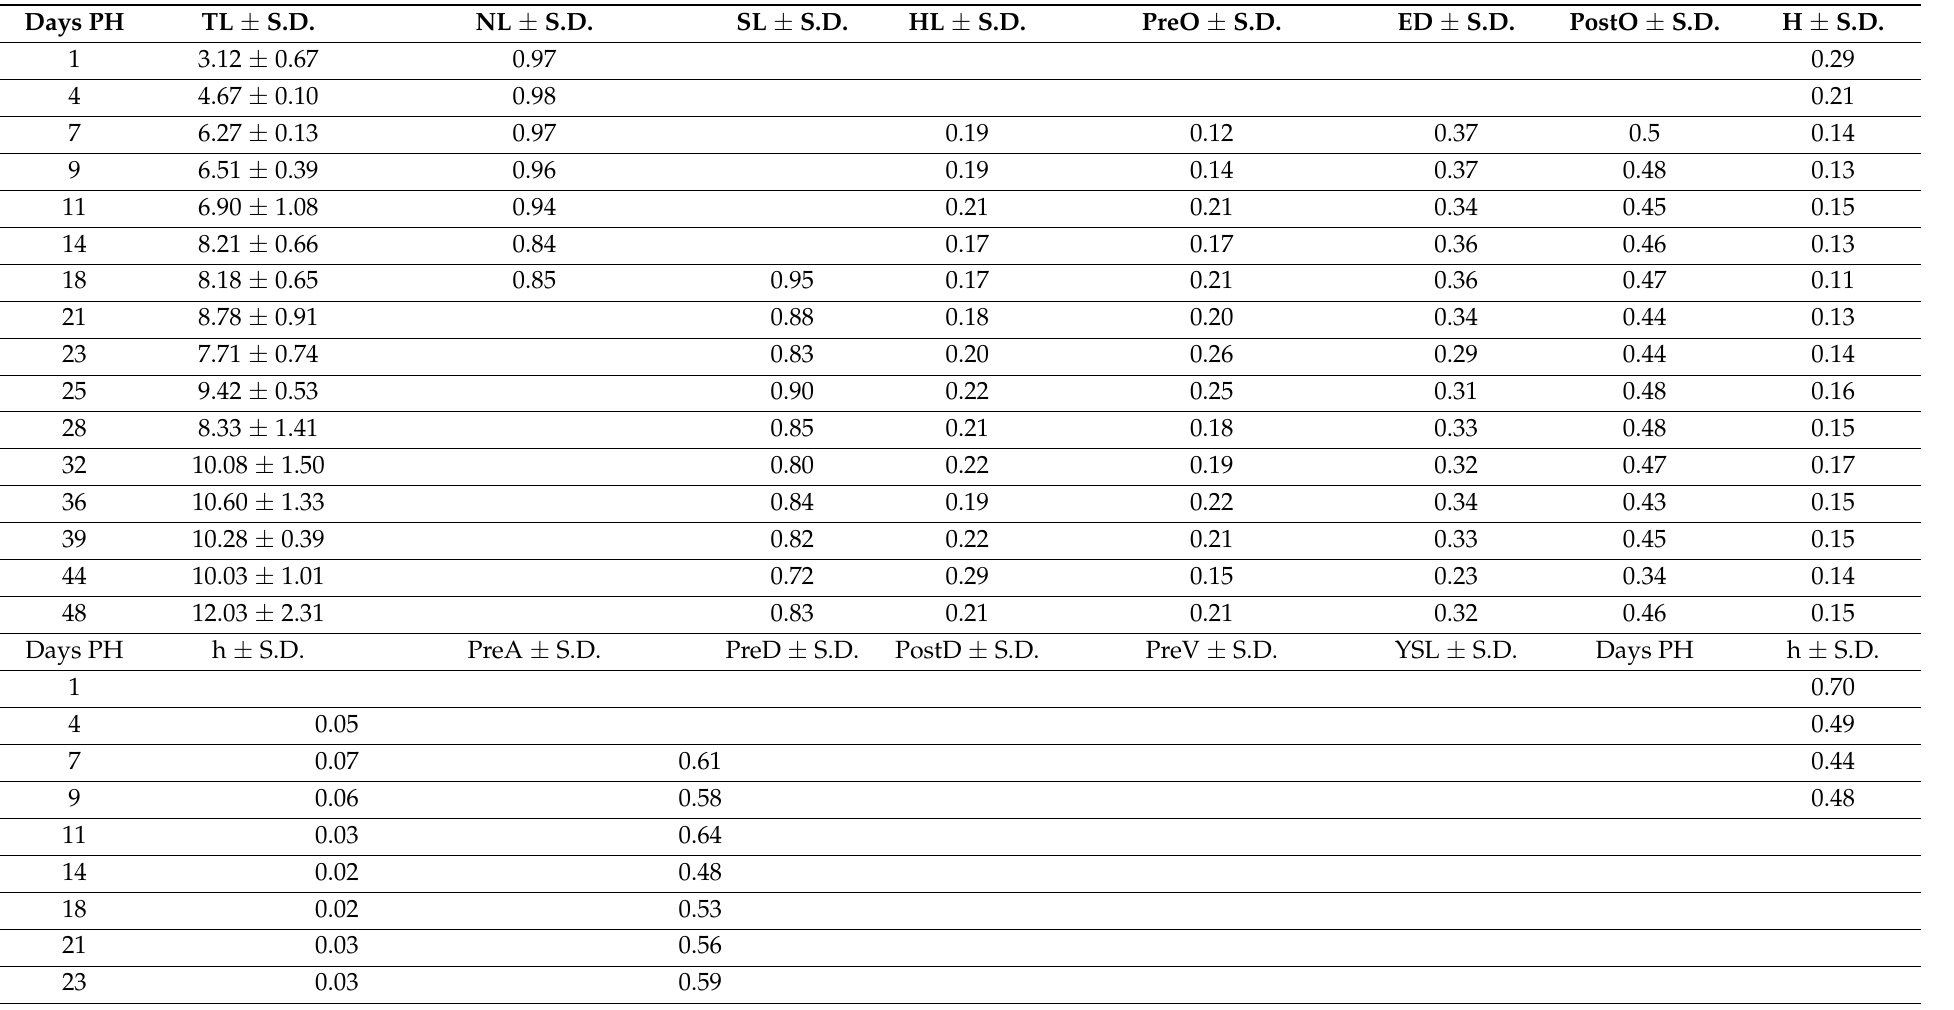
Table 1. Mean values and standard deviation for TL (in mm) and percentages of morphometric measurements (%) of Delminichthys krbavensis . Percentages of morphometric measurements were calculated as a ratio of TL to NL, SL, H, h, PreA, PreD, PostD, PreV, YLS and as HL to PreO, ED and